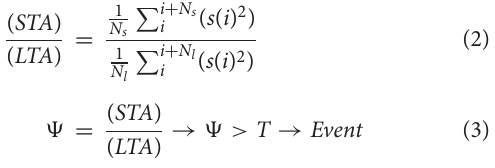
FIGURE 7 | Mean frequency evolution (normalized with the maximum value 200kHz) during injection. As the channel network develops progressively the energy percentage in the low frequency range f < 10kHz diminishes, and the mean frequency gets higher. A cubic polynomial curve (red) is fitted to the mean frequency data to simplify the comparison and discussions. The location of the inflection point of this curve is indicated by the (red) dash dot strip ( t 0 1 . 49 s). In this curve the normalized maximum finger = length (green, maximum value is approximately 35cm) and the carved area (black, maximum value is approximately 270 cm 2 ) is also presented.The area saturates to a maximum at a time close to t 0 . The length still increases slightly after t 0 , in particular, a small step in finger length (high slope of the length curve, corresponding to a large stick slip event connected to the finger) can be noticed around t 0